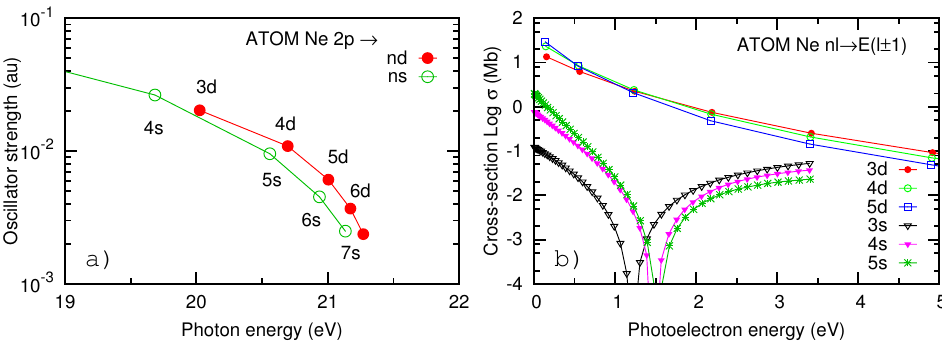
Figure 3. ( a ) Oscillator strengths of the 2 p → nd and 2 p → ns transitions in Ne from the ATOM calculation; ( b ) partial photoionization cross-sections for the nl → E ( l ± 1 ) transitions. Table 1. Binding energies E nl and oscillator strengths f nl of Ne in atomic units. The TDSE calculations with the LHF potential are compared with the ATOM calculations with the non-local HF potential. The experimental binding energies are from [24]. nl Binding Energy E nl , au